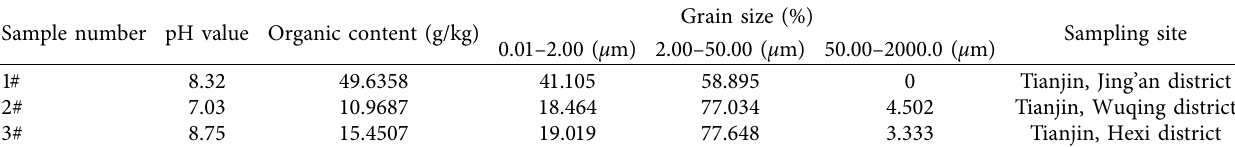
Table 1: Properties and locations of diferent sediments. Grain size Sample number pH value Organic content (g/kg)